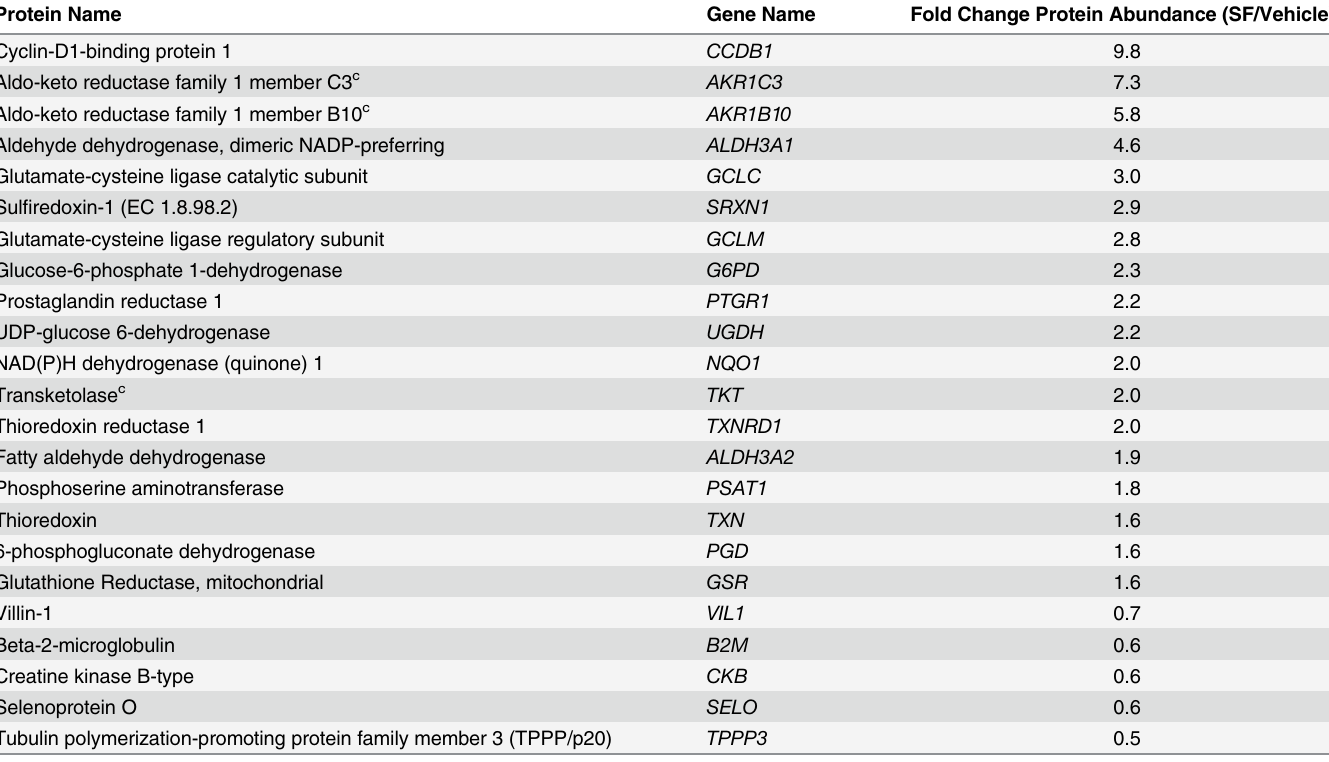
Table 1. Fold changes in protein abundance for SF-treated HT29 cells compared to untreated counterparts. a